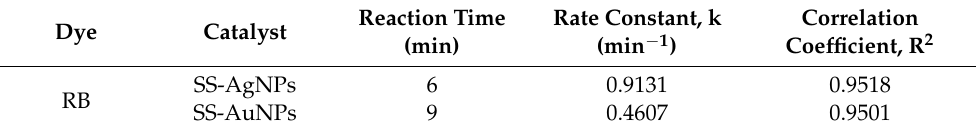
Table 2. Values of rhodamine B (RB) reduction.